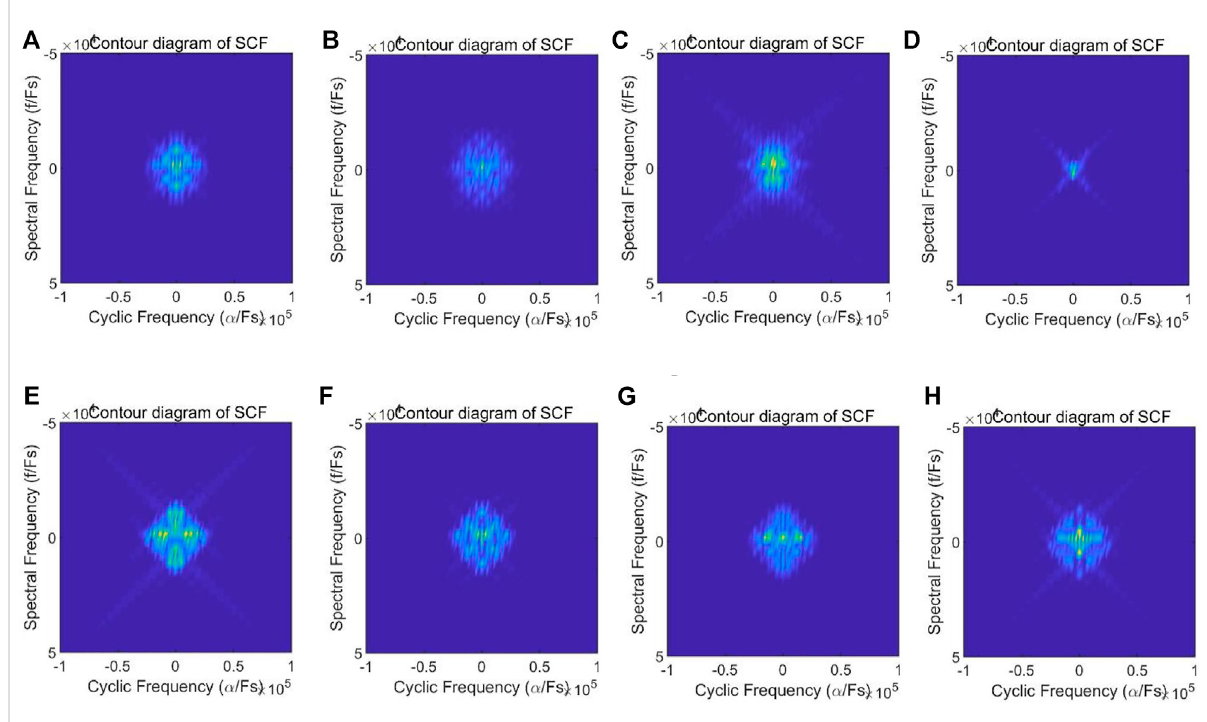
FIGURE 4 Contour diagram of spectral correlation function of modulated signals at SNR = 18 dB in RadioML 2016.10A dataset. (A) 8PSK, (B) BPSK, (C) CPFSK, (D) GFSK, (E) PAM4, (F) QAM16, (G) QAM64, (H) QPSK.